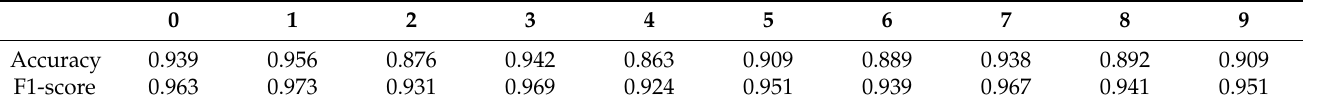
Table 5. 10-fold cross-validation results for